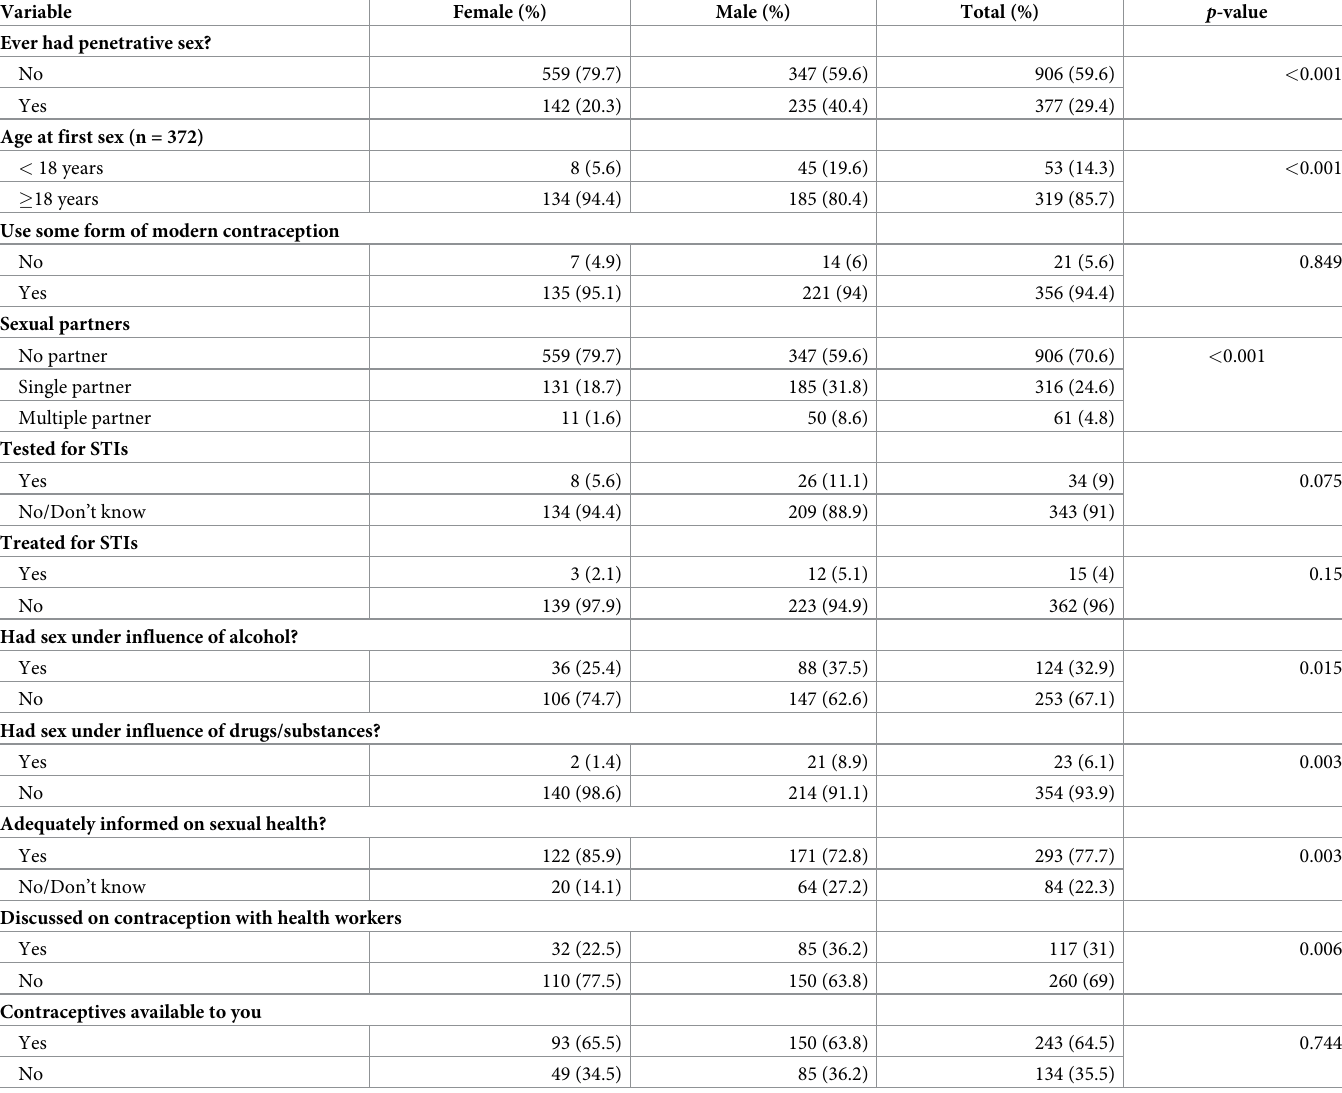
Table 2. Contraceptive use and risk behaviour of the university students of